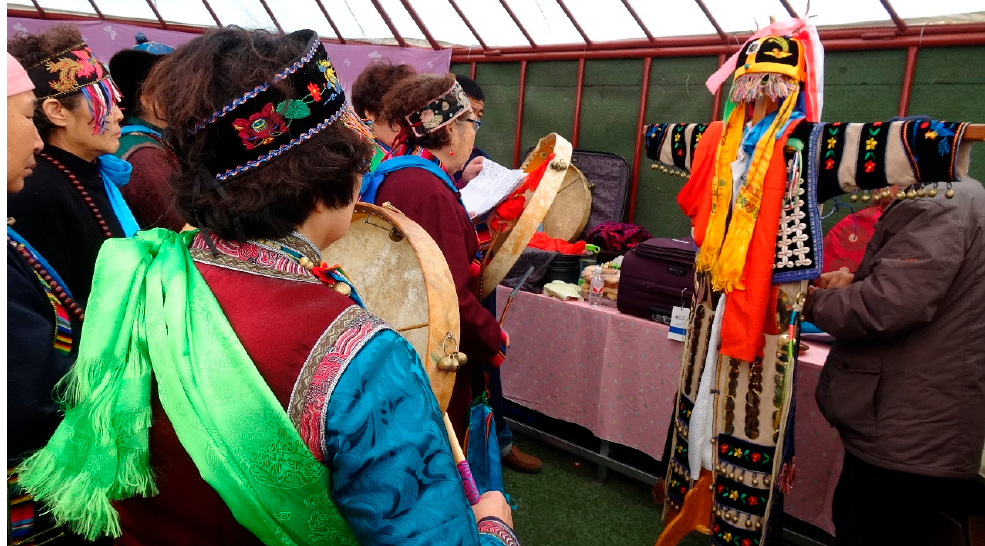
Figure A7. amilabe (Give life, make it actively), to consecrate (“ 开光 ”, opening the light) for the new shaman’s sama ːʃ ə k (shaman vestment). (On 6 October 2017, Wo Liming’s initiation ritual as jad’ ə n ). Photo: Minna Sa, 2017.